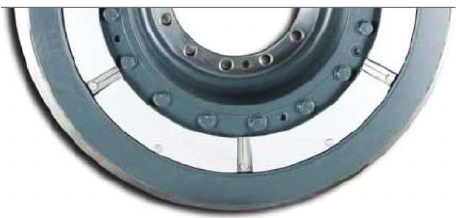
Figure 12: Tram wheel with 6 dampers installed on